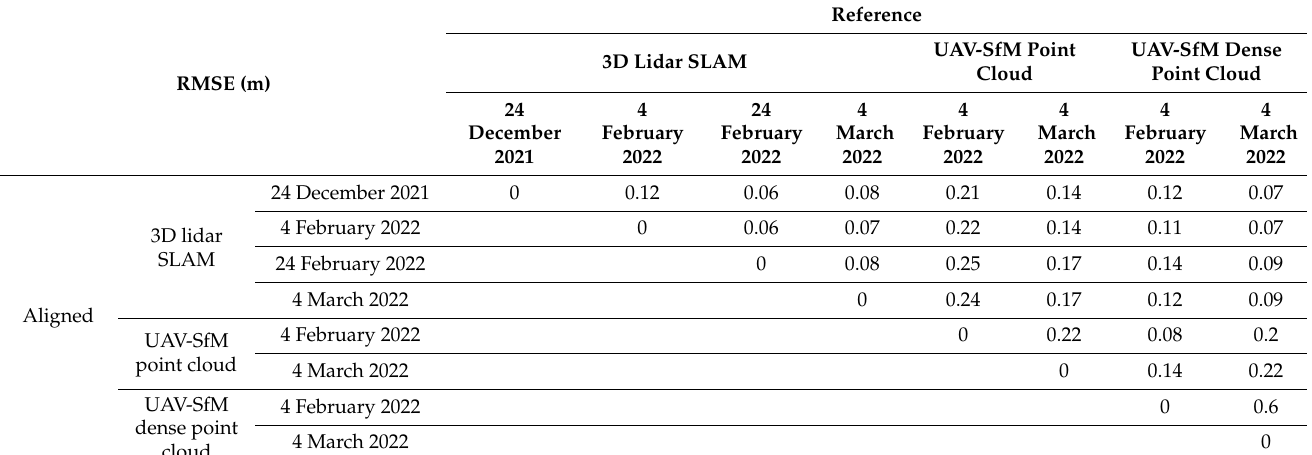
Table 2. Comparison of the point cloud differences for each